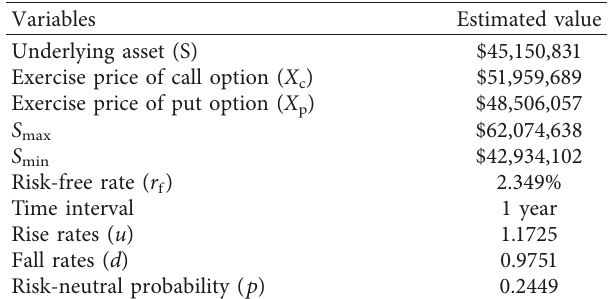
5: Maximum and minimum values of